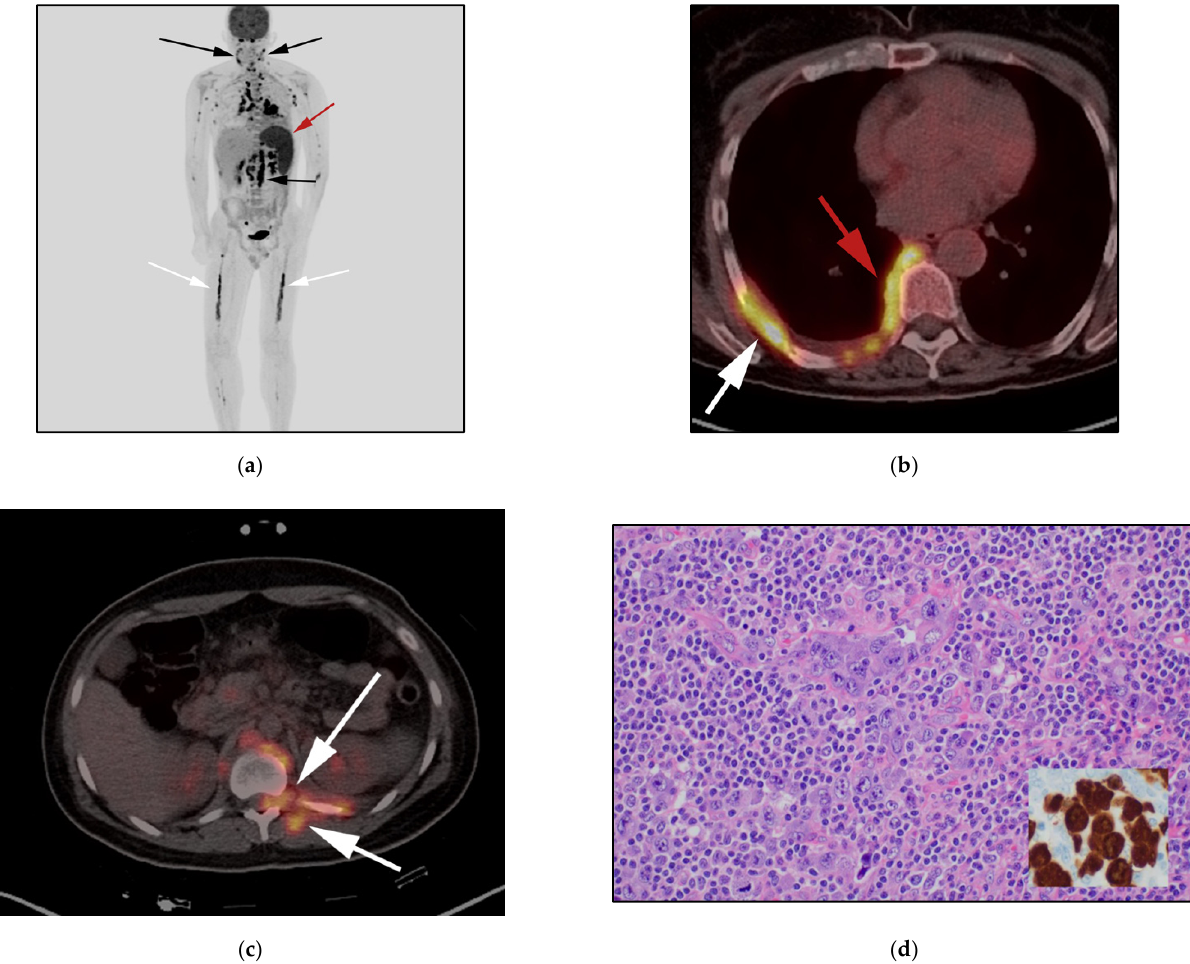
Figure 3. A 22-year-old male diagnosed with systemic ALCL, ALK-negative variant. ( a ) F-18 FDG PET/CT maximal intensity projection (MIP) image, showing diffuse hypermetabolic adenopathy throughout the neck, chest, and abdomen (black arrows), diffuse osseous activity within lower extremities, consistent with marrow infiltration (white arrows). Additionally, note increased activity within the spleen, consistent with splenic infiltration (red arrows). ( b ) F-18 FDG PET/CT axial image in a different patient, shows hypermetabolic circumferential right pleural mass (red arrows) associated with right seventh rib-destructing mass (white arrow). ( c ) 18 FDG PET/CT axial image in a different patient, shows extensive hypermetabolic soft-tissue masses along left 12th rib with extension into the T12-L1 left neural foramen and epidural space, consistent with perineural spread. This again was biopsy-proven systemic ALCL, ALK-negative variant (white arrow). ( d ) Histologic section shows cohesive sheets of tumor cells with anaplastic features resembling nonhematopoietic metastatic tumors of the lymph node. Note the large hallmark cells showing eccentric kidney shaped nuclei. The tumor cells strongly express CD30 and ALK-1 expression. (Original magnification 400 ×, H&E stain)